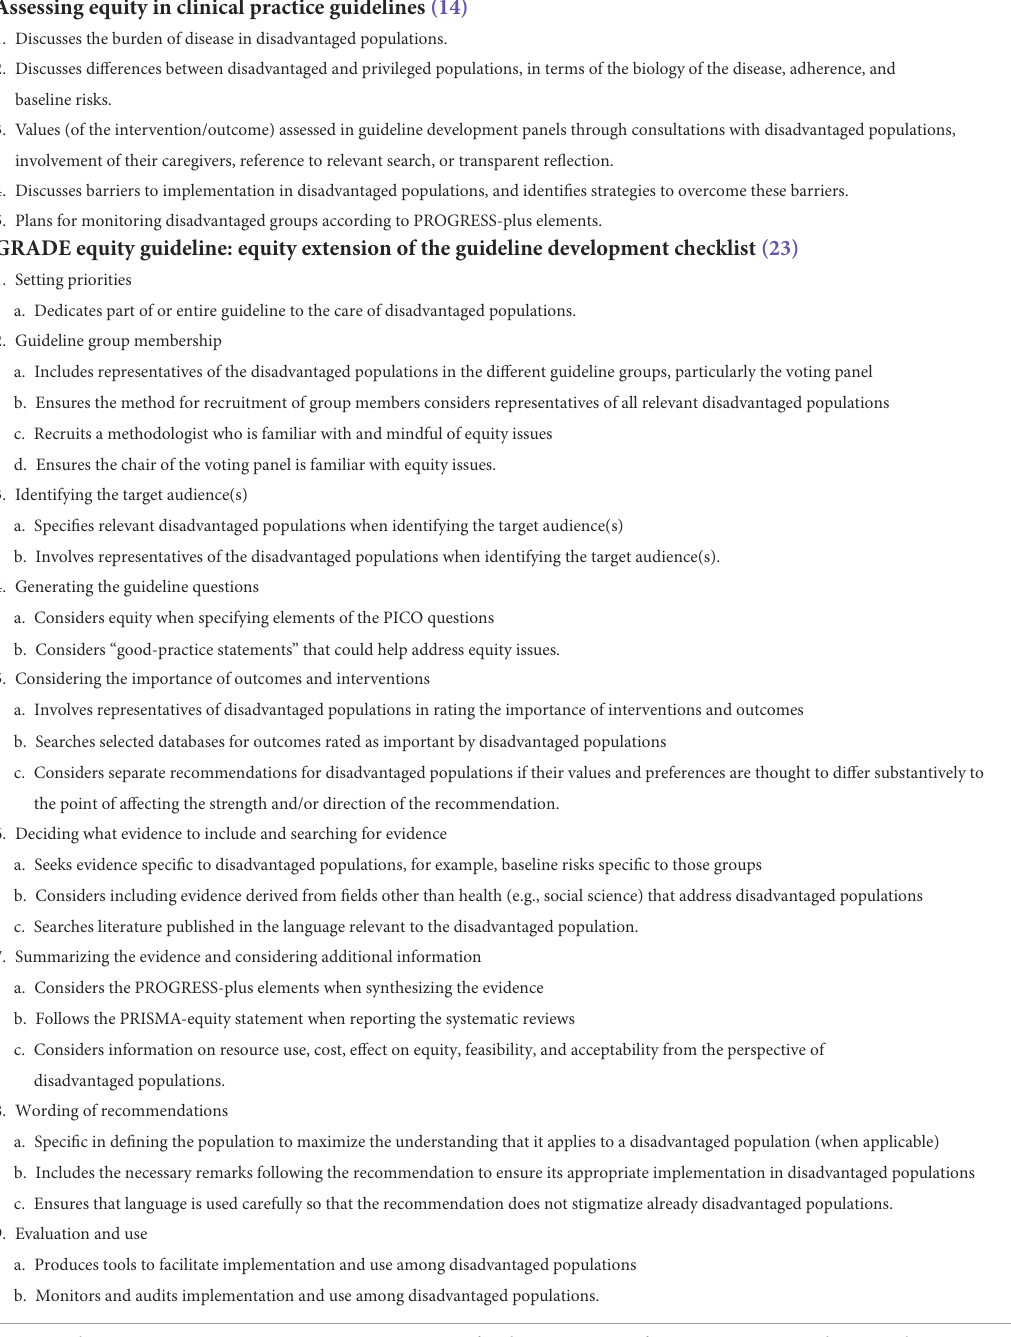
TABLE 3 Quality appraisal checklist to assess equity in clinical practice